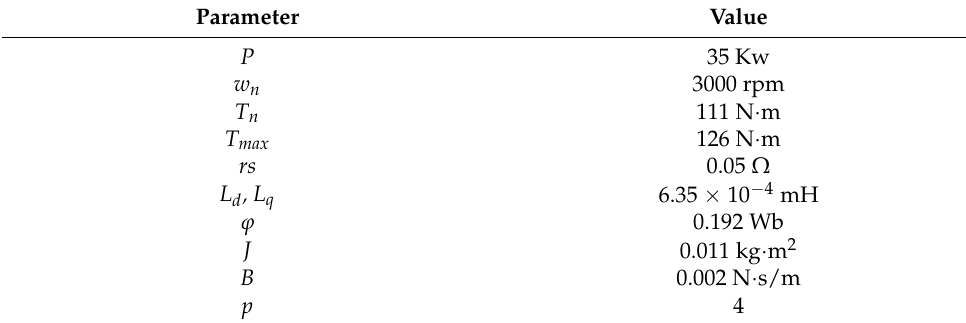
Table 4. BEV and environment